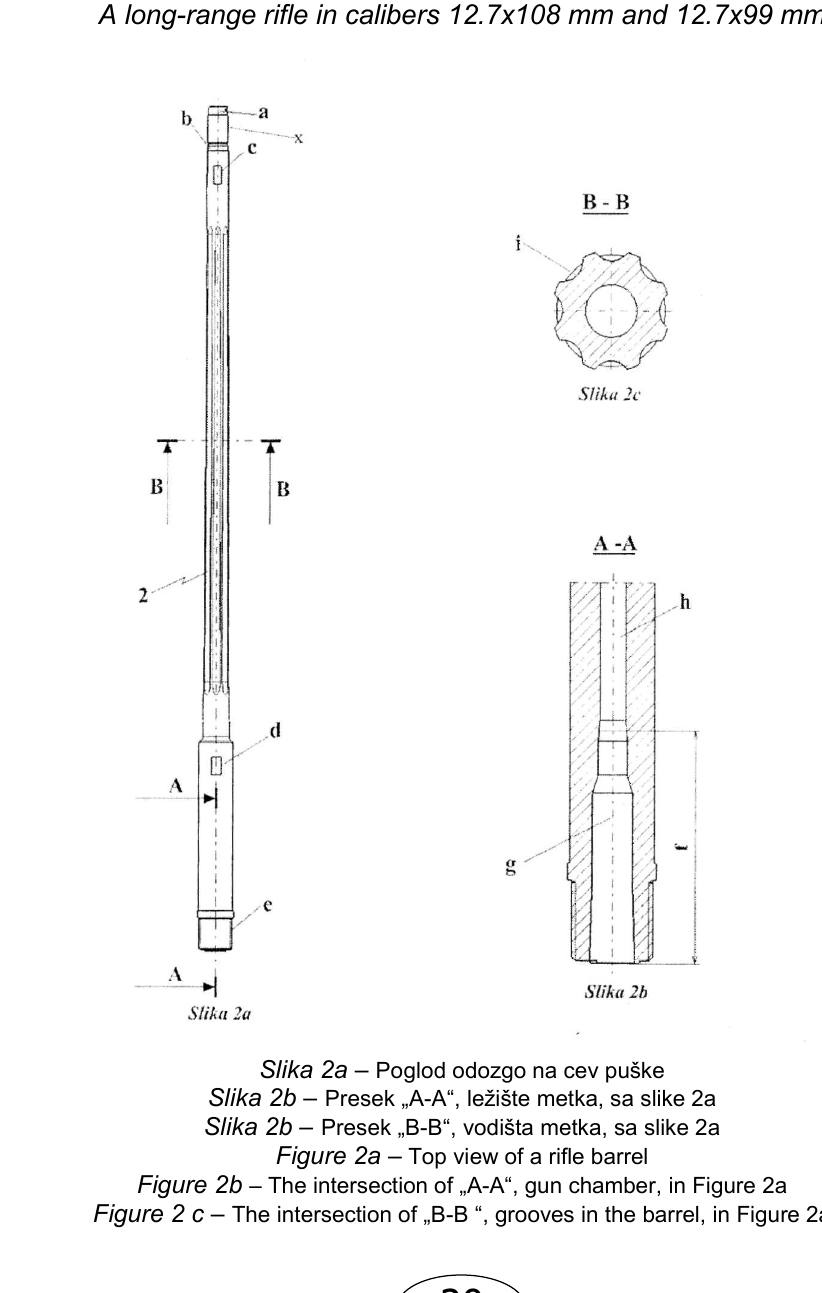
Figure 2a – Top view of a rifle barrel Figure 2b – The intersection of „A-A“, gun chamber, in Figure 2a Figure 2 c – The intersection of „B-B “, grooves in the barrel, in Figure